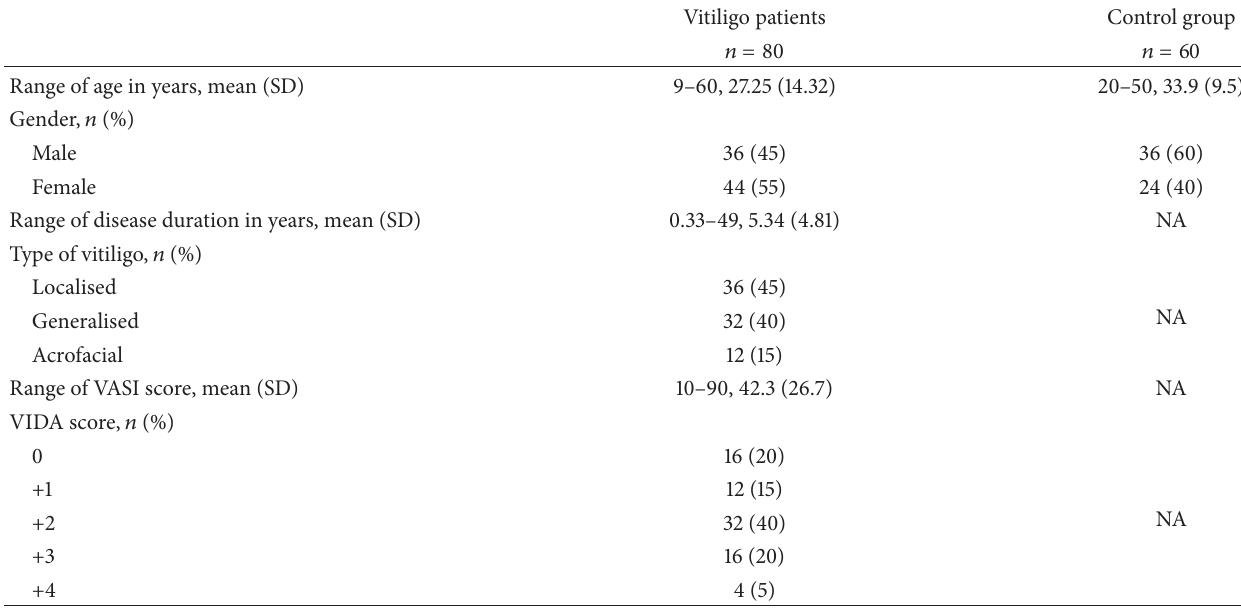
Table 1: Demographic and clinical characteristics of study